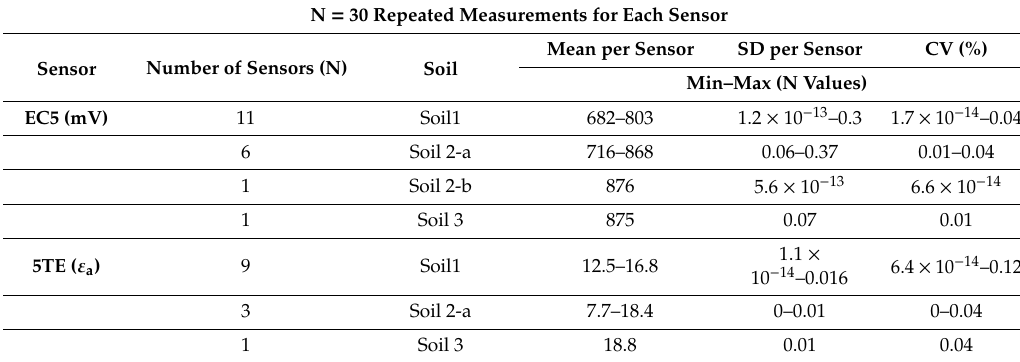
Table 3. Statistics of the repeatability measurement of the two sensors in soil. N = 30 Repeated Measurements for Each